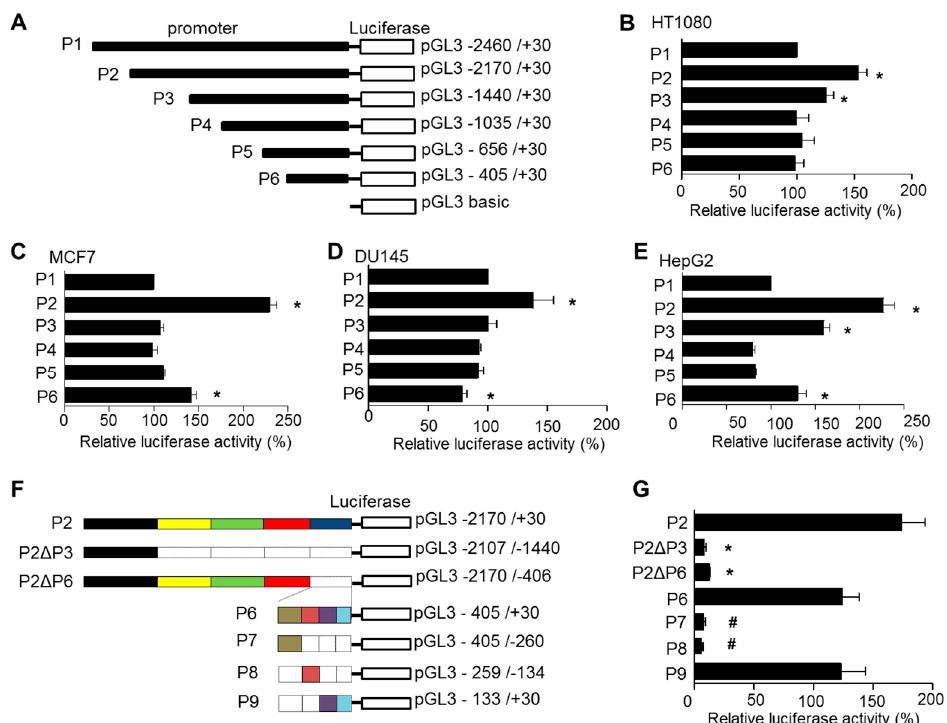
Figure 2. Characterization of the human TMBIM6 promoter. ( A ) Schematic presentation of a series of 5 ′ flanking region deletion constructs between − 2460 and +30 of TMBIM6. Each construct was made in the pGL3-basic promoter-less luciferase reporter plasmid. Constructs were named P1–P6, and the nucleotide numbers of each construct are relative to the TSS. ( B – E ) Each construct was transfected into HT1080 ( B ), MCF-7 ( C ), Du145 ( D ), and HepG2 ( E ) cells, and the luciferase activity was measured after 24 h and normalized to β -gal activity to account for transfection efficiency. The luciferase activity of each construct is presented relative to the activity of the pGL3-basic vector. The results are the mean ± SD from n = 3 independent experiments. ‘*’ indicates signi fi cant differences from the P1. ( F ) Show the design of the P2 deletion constructs and fragmented P6 constructs in the pGL3-basic reporter vector. Empty boxes represent the deleted positions. The nucleotide positions of each construct are relative to the TSS. ( G ) Relative luciferase activity of each truncated P2 constructs and fragmented P6 constructs P7, P8 and P9; P9 construct is identified as the core promoter of TMBIM6. The results are the mean ± SD from n = 3 independent experiments. ‘*’ indicates signi fi cant differences from the P2. ‘#’ indicates significant differences from P6.